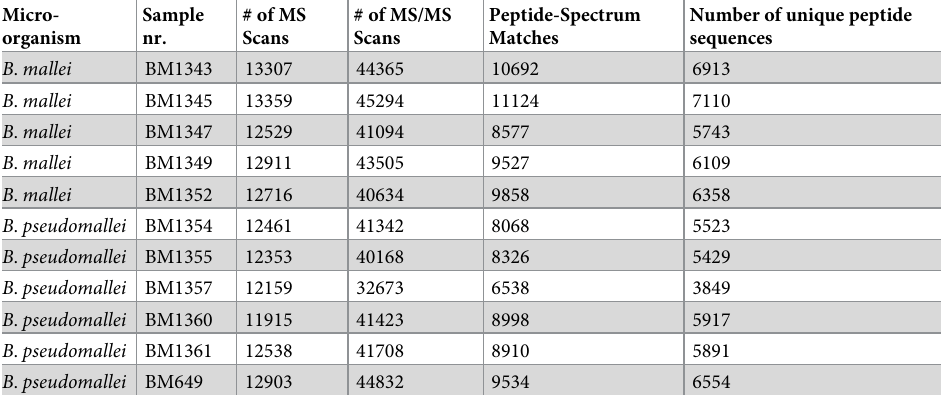
Table 4. On a Orbitrap Fusion Lumos mass spectrometer generated MS-spectra (MS scans and MS/MS scans) of each isolate included and the number of identified peptides using the MS2peptides-DB. Micro- Sample organism nr.